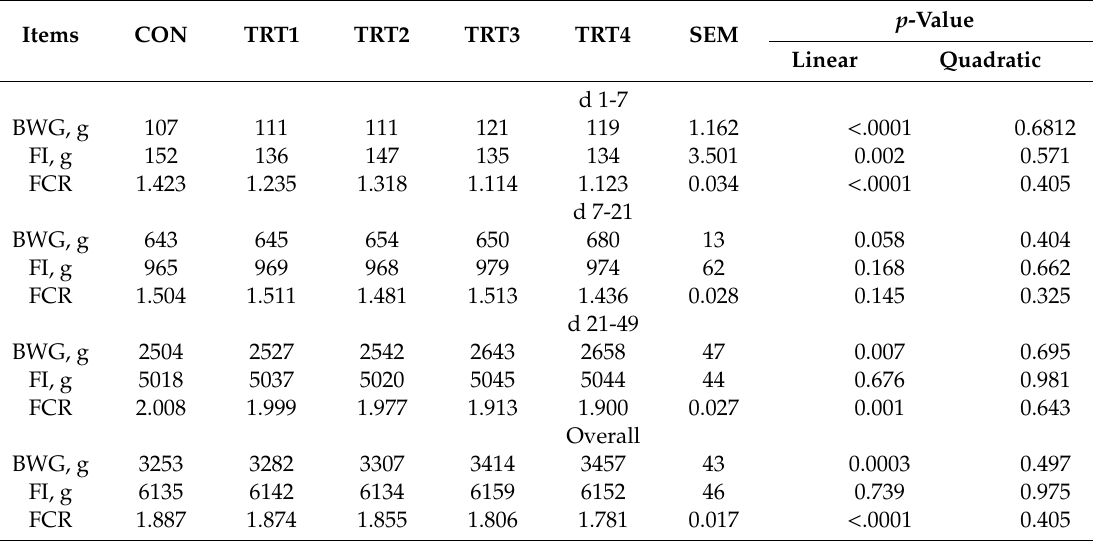
Table 2. E ff ect of coating the blend of OAs and MCFAs supplementation on growth performance in